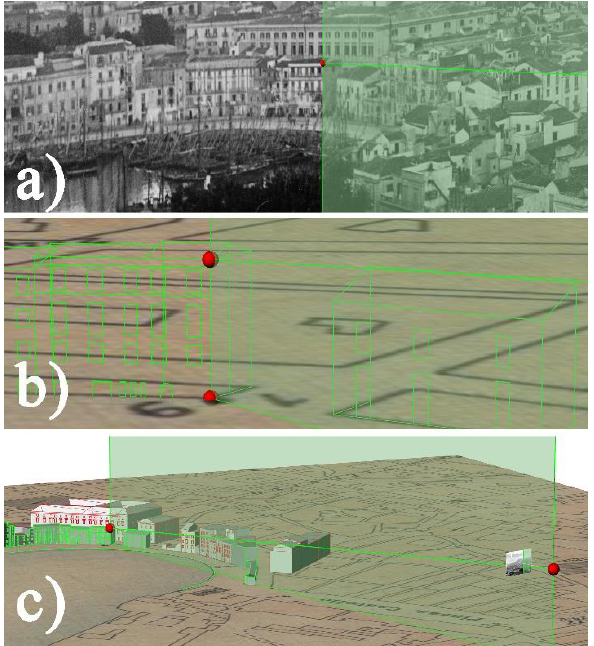
Figure 6: The Reconstruction